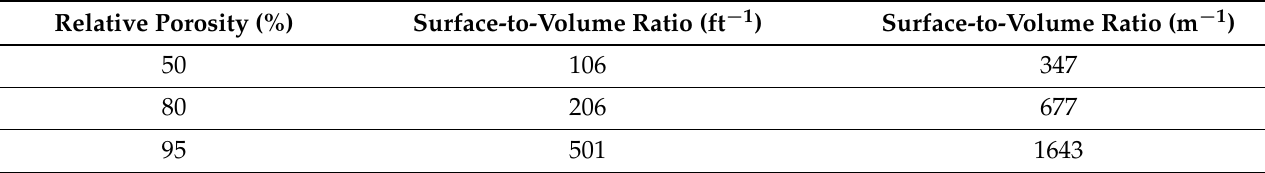
Table 2. Surface-to-volume ratio of the 3D-printed